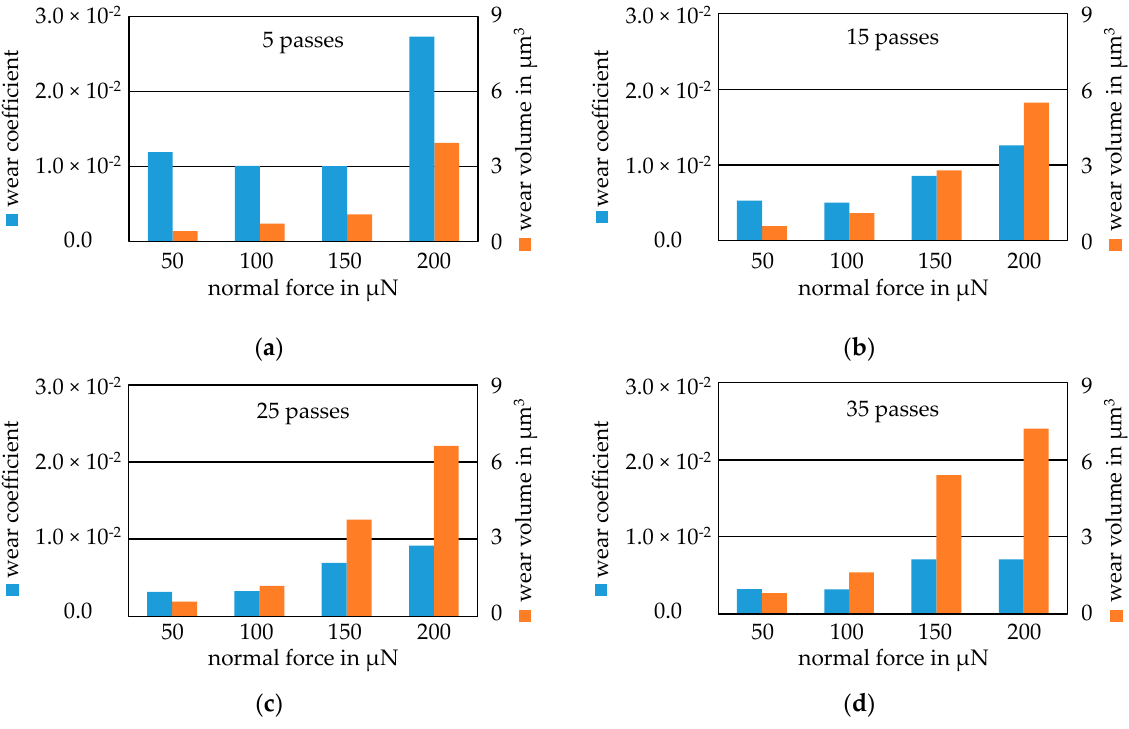
Figure A5. Development of the average wear volumes and average coefficients of wear over the normal forces of the MoO 3 ‐ coating: ( a ) 5 passes; ( b ) 15 passes; ( c ) 25 passes; ( d ) 35 passes.